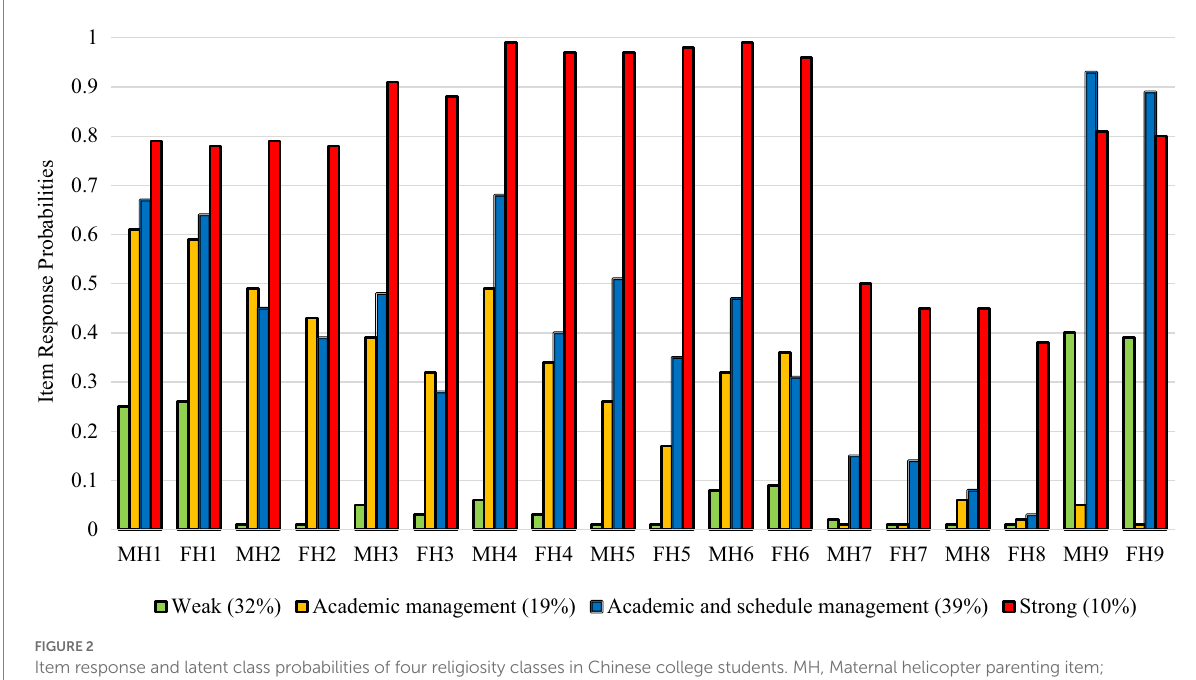
FIGURE 2 Item response and latent class probabilities of four religiosity classes in Chinese college students. MH, Maternal helicopter parenting item; FH, Paternal helicopter parenting item. Item 1, Advise my college major; Item 2, Monitor my exercise schedule; Item 3, Call parents to know where I am; Item 4, Monitor my diet; Item 5, Monitor who I spent time with; Item 6, Call me to track my schoolwork; Item 7, Call professor about a low grade; Item 8, Intervene my roommate issue; Item 9, Have a curfew every